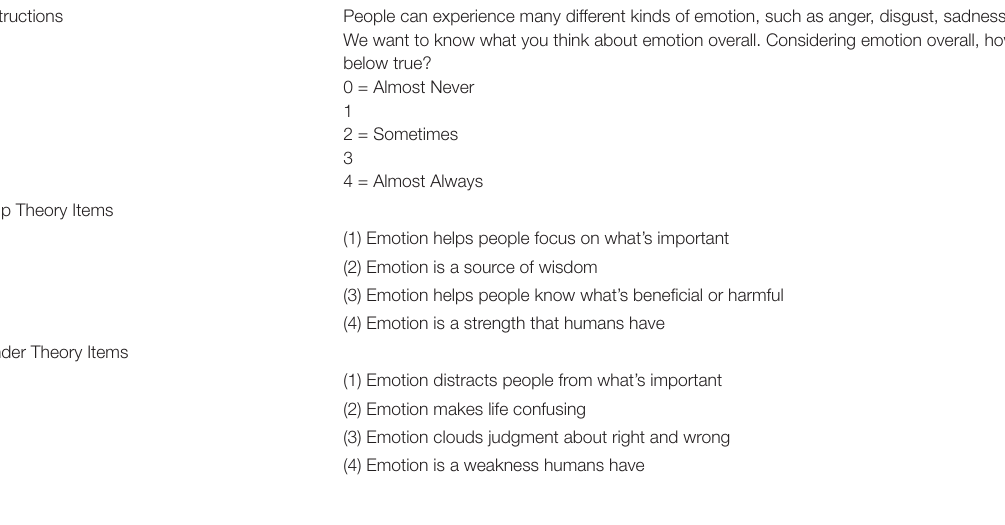
TABLE A1 | Items and instructions for Help and Hinder Theories about Emotion (HHTEM)